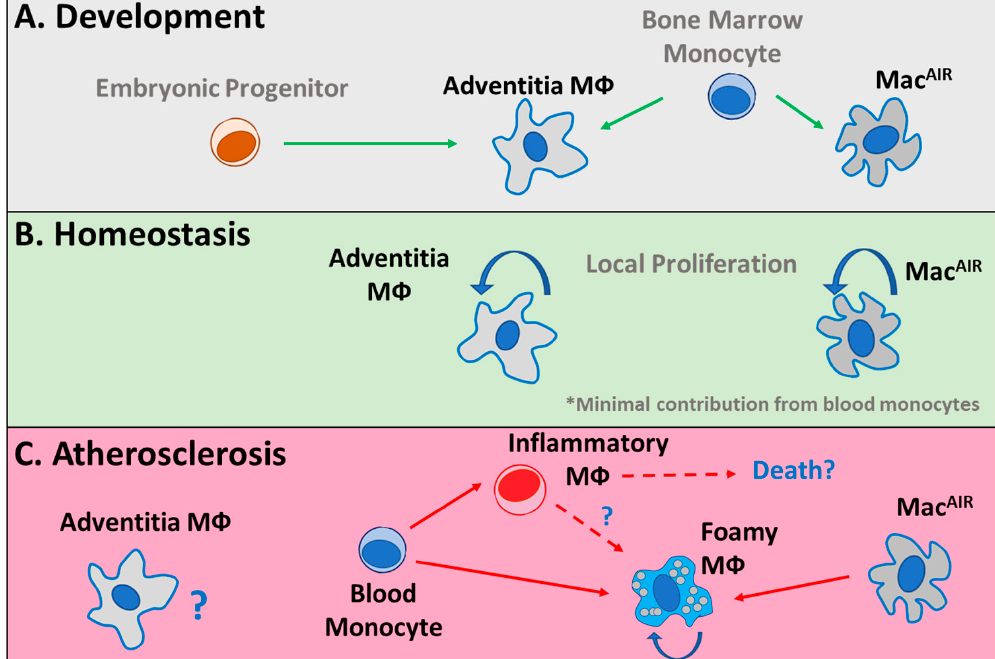
Figure 2. Monocyte and macrophage dynamics in the aorta. ( A ) Adventitia macrophages (M φ ) that develop during embryonic development and immediately following birth are complemented by a wave of monocytes. In the intima, aorta-intima-resident macrophages (Mac AIR ) develop from bone marrow monocytes immediately following birth. ( B ) During homeostasis, adventitia and Mac AIR are maintained in their respective tissues, independent of additional monocyte supplementation, through local proliferation. ( C ) During atherosclerosis, the role of adventitia macrophages is poorly described and their relationship with plaque-associated macrophages is unknown. During disease progression, Mac AIR are the initial cells to differentiate into foamy macrophages. Subsequently, monocytes infiltrate into tissue and differentiate into inflammatory or foamy macrophages. The interactions between these monocyte-derived cell types and their potential contributions to cell death pathways are unclear.